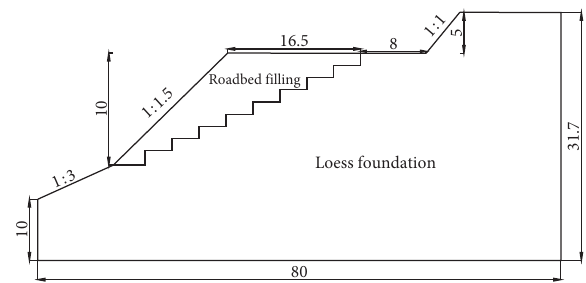
Figure 1: Calculation model for half-filled and half-cut subgrade (unit: Table 2: Pavement structure and material parameters.